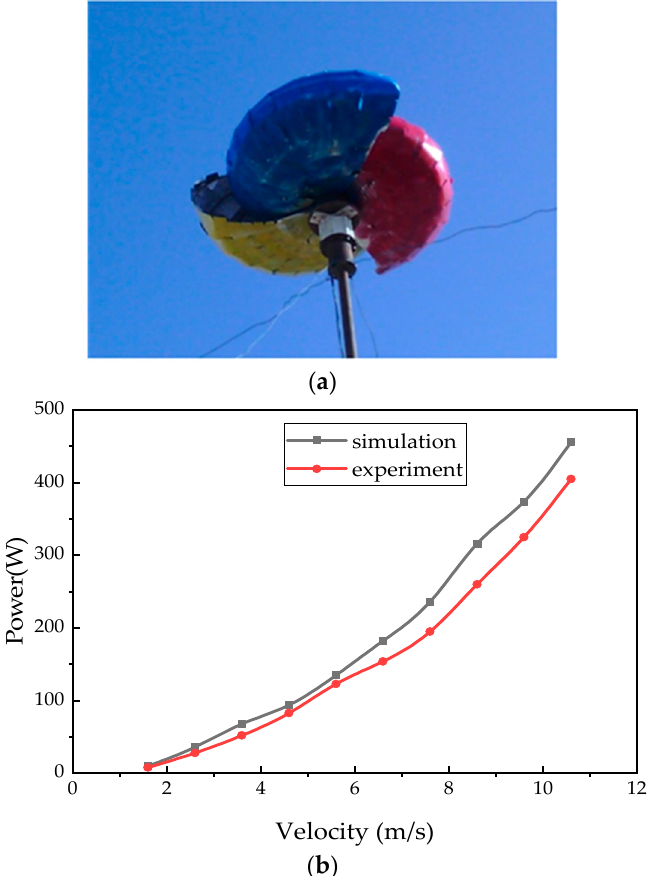
Figure 21. ( a ) Wind turbine prototype; ( b ) Comparison curve of measured power and simulated power.